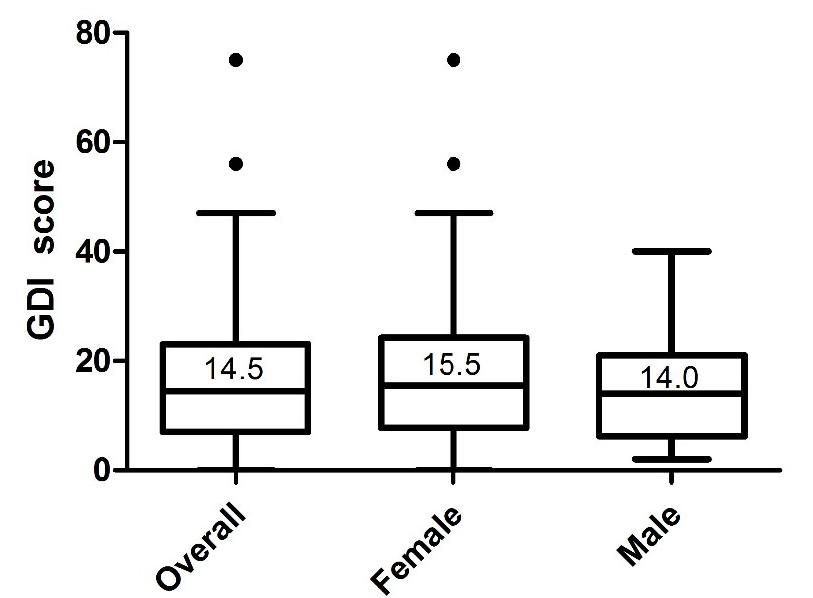
Figure 2. Distribution of the Graz Dysfunction Index scores in the study sample (n = 74). Median (interquartile range): 14.5 (7–23) in the total sample; 15.5 (7.8–24.3) in females; 14.0 (6.3–21) in males; p ‐ value = 0.40; Mann–Whitney U ‐ test. Table 1. Median (interquartile range) of Graz Dysfunction Index scores in subscales, by gender. Graz Dysfunction Index Score Anamnesis and inspection